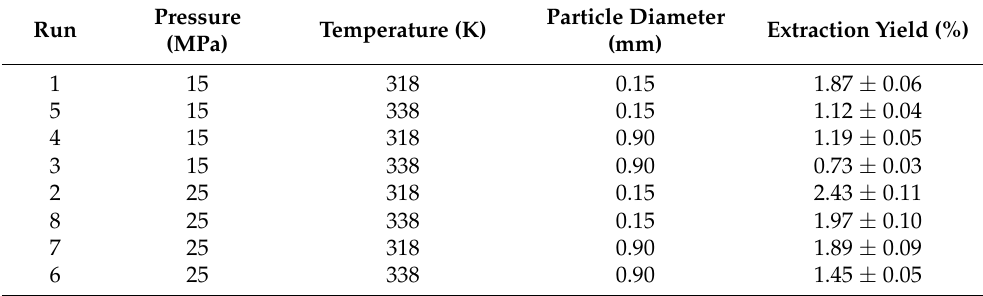
Table 1. Yield of extraction of rosemary essential oil by supercritical fluid extraction.